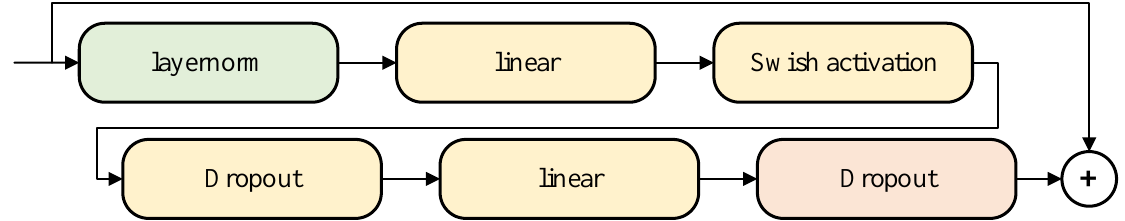
Figure 12. Feed-forward module.